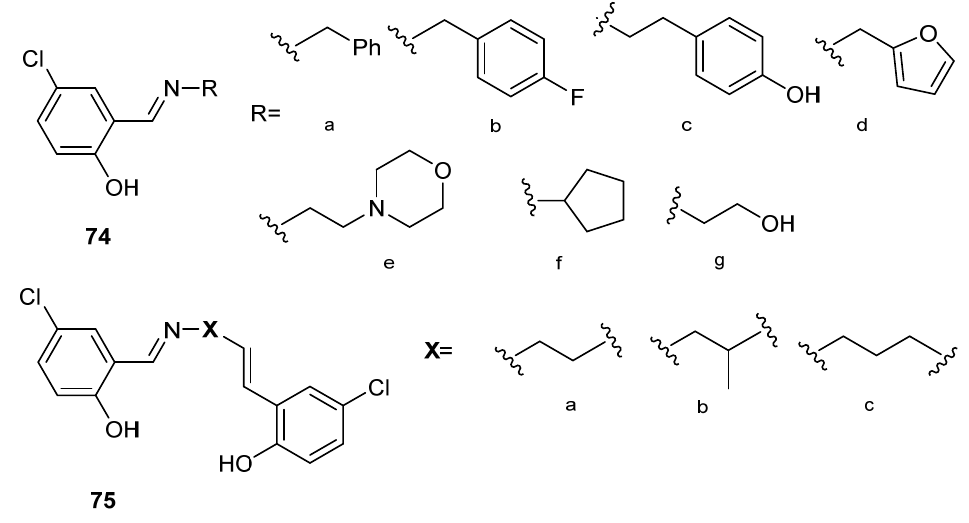
Figure 5. 5-chloro-salicylaldehyde-Shiff bases.